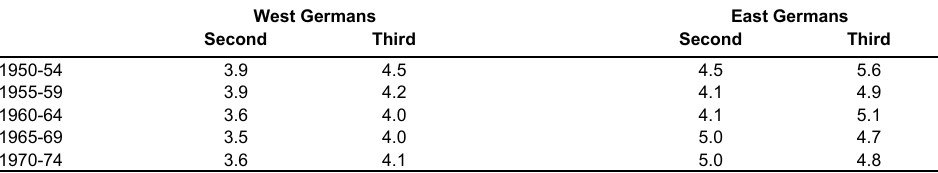
Table 1b : Average duration since last birth, by birth cohort and region West Germans East Germans Second Third Second